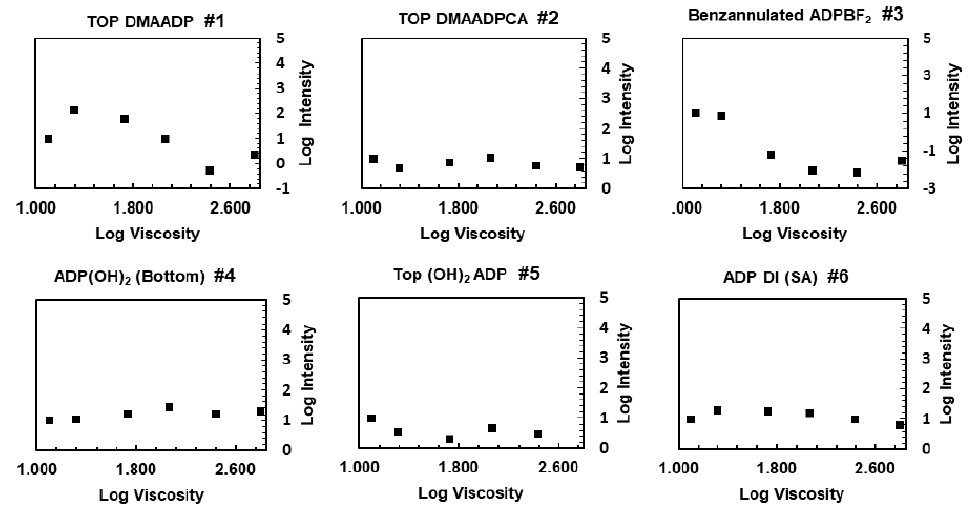
Figure 4. Fluorescence intensity in response to the change in the viscosity.